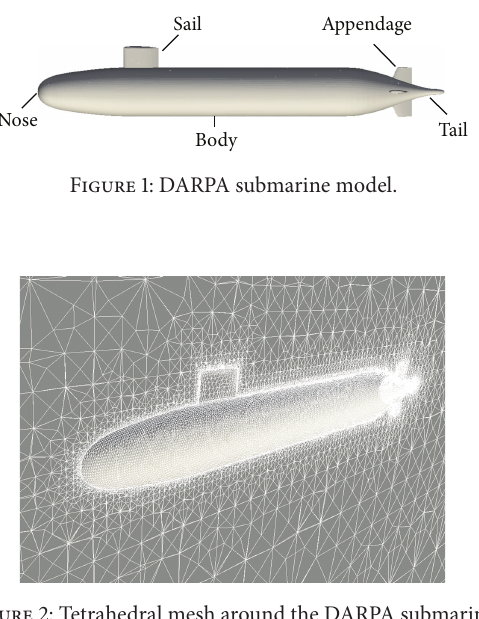
DARPA submarine [8, 9] are of the geometry length, 4.355 m; cylinder body diameter, 0.507 m; tail diameter, 0.0075 m and sail height, 0.206 m.